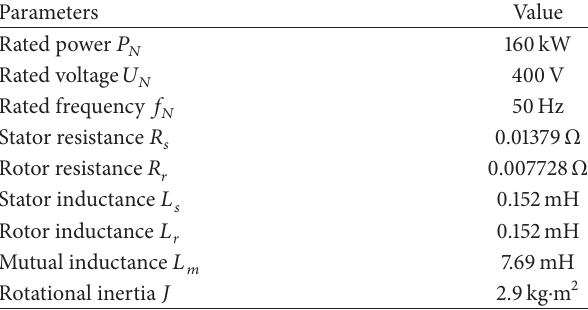
Table 2: Parameters of three-phase asynchronous motor.